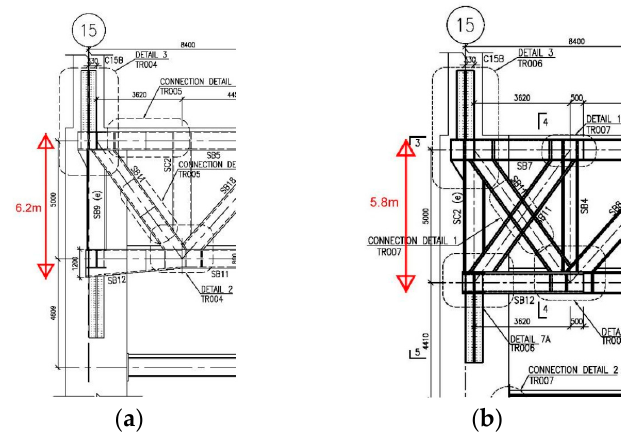
Figure 10. Increase of headroom at 3/F. ( a ) Original single truss scheme; ( b ) Optimal twin truss scheme.